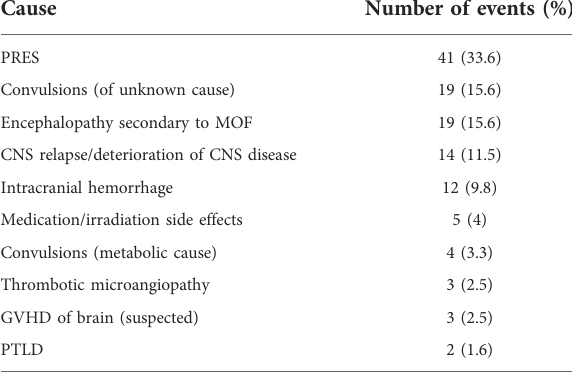
TABLE 2 Causes of noninfectious neurological complications (122